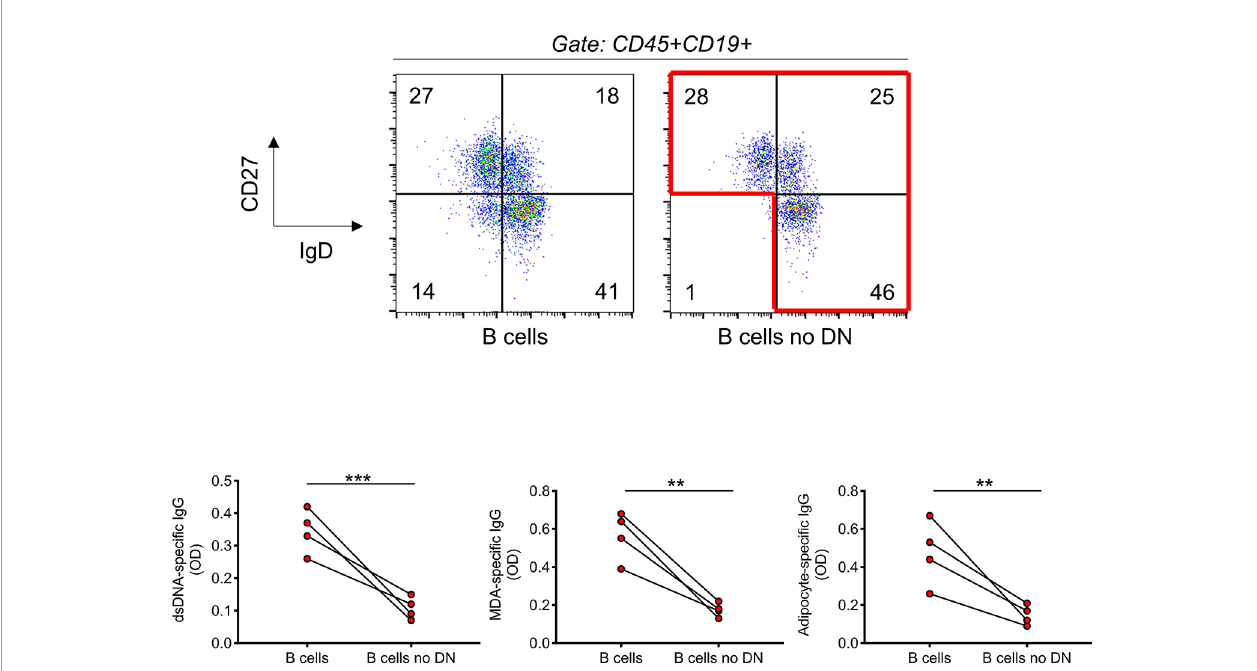
FIGURE 6 | The removal of DN B cells signi fi cantly reduces the secretion of IgG autoimmune antibodies. B cells were isolated with magnetic beads from the blood of four individuals with obesity. Top. Gating strategies to remove DN B cells. B cells were stained with anti-CD27 and anti-IgD antibodies. DN B cells were sorted out using a Sony SH800 cell sorter. Bottom. After stimulation of total B cells and total B cells without DN B cells for 10 days with CpG, supernatants were collected and analyzed for the presence of anti-dsDNA, anti-MDA, and anti-adipocyte IgG by ELISA. **p < 0.01, ***p <